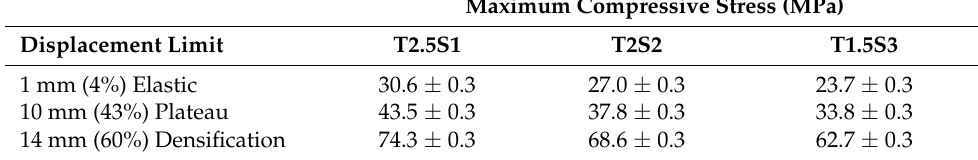
Table 6. Variation in compressive